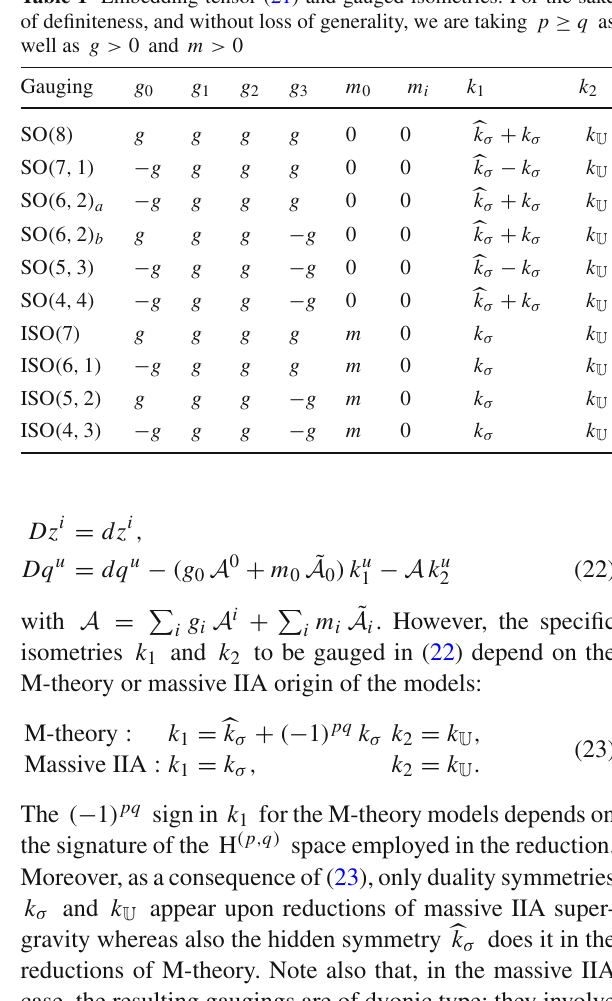
Table 1 Embedding tensor (21) and gauged isometries. For the sake of definiteness, and without loss of generality, we are taking p ≥ q